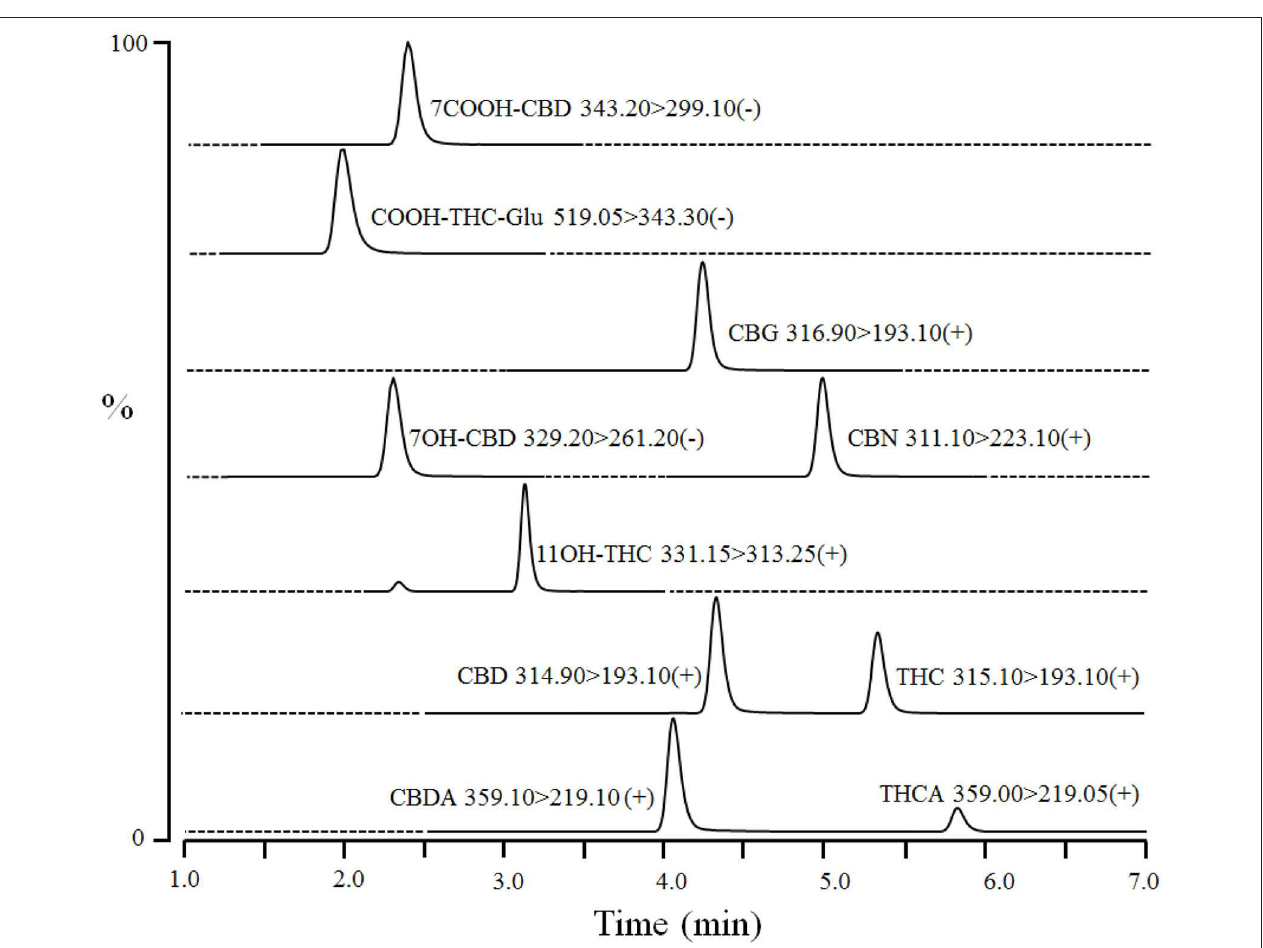
FIGURE 1 | A representative chromatogram of cannabinoids and their metabolites in fortified dog serum at upper limit of quantitation (1,000ng/mL of each compound). The compound name with corresponding Multiple Reaction Monitoring (MRM) transition and polarity is given in the inset of each chromatogram. Dashed-line represents the diversion of MS detector for a particular MRM transition and